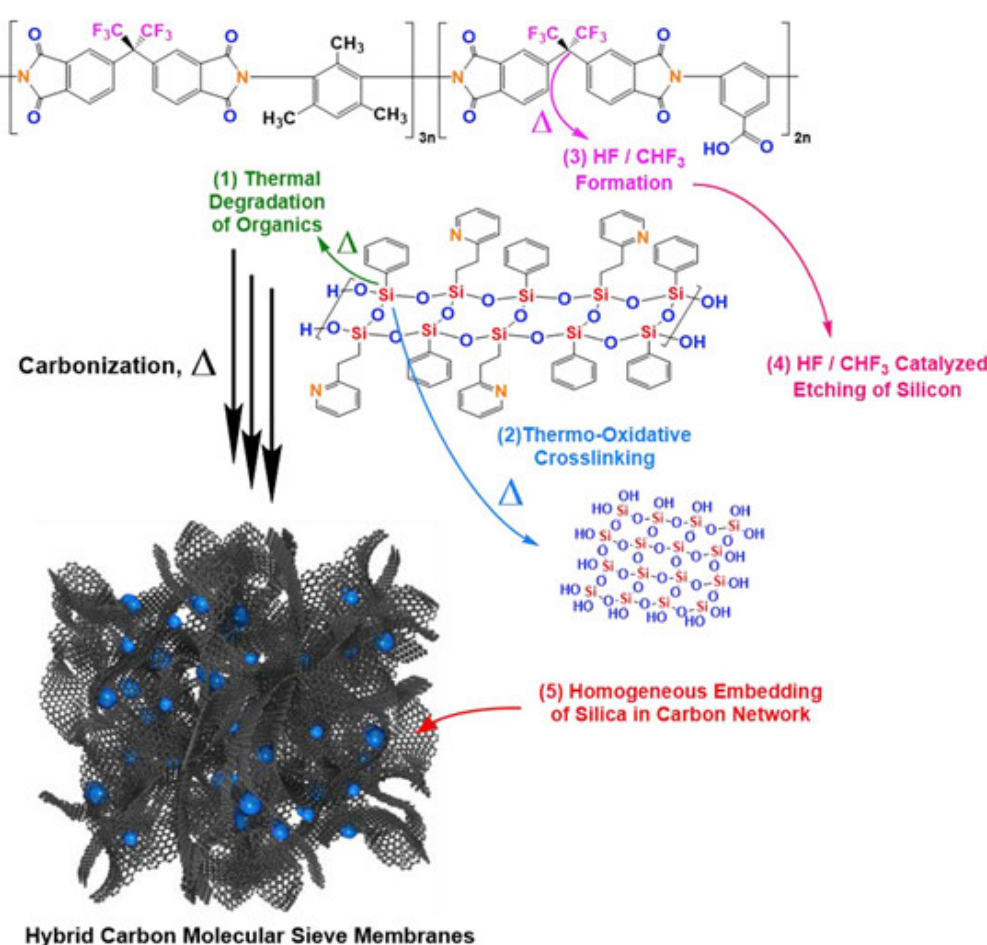
Figure 15. Nanoporous carbon-silica membrane derived from 6FDA-DAM/DABA and LPSQ. Adapted from [94] with permission. Copyright (2020) Elsevier.